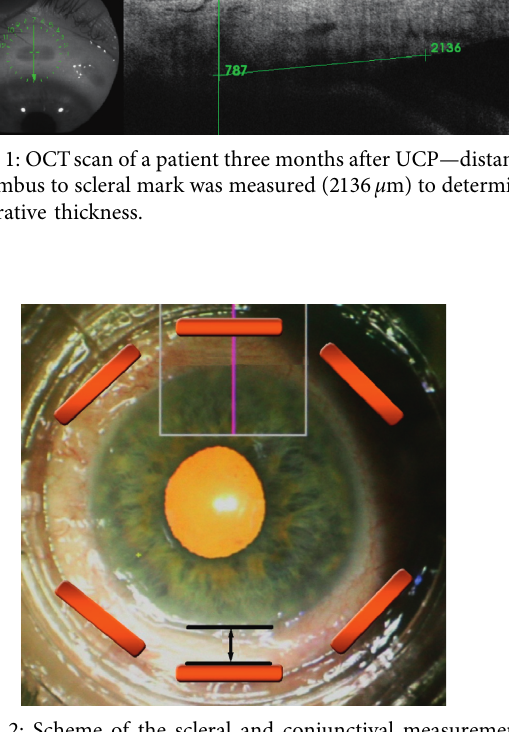
Figure 2: Scheme of the scleral and conjunctival measurements after UCP. OCT scans were taken in a projection perpendicular to the limbus of the cornea in the superior and inferior quadrants of the eye (purple continuous line). Thickness values were measured equidistant from the limbus (black continuous line) where the scleral mark occurred (orange rectangle).